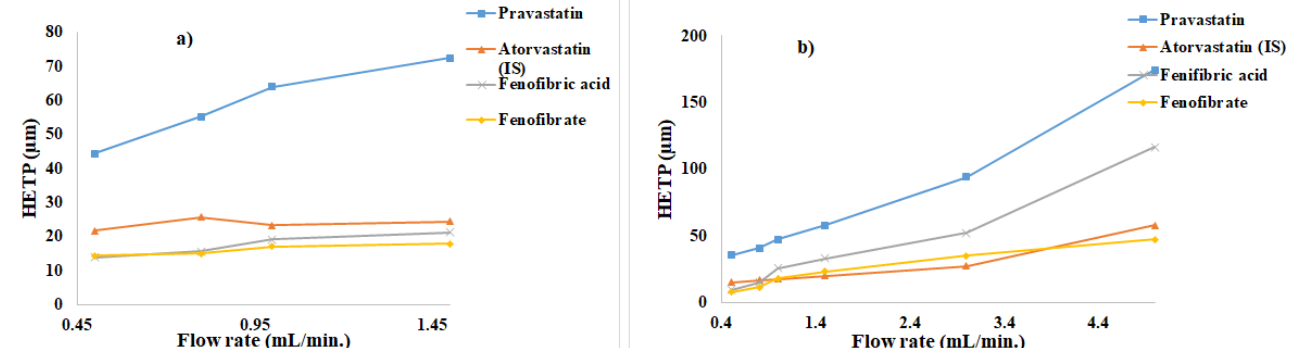
Figure 4. Van Deemter plot of the Height Equivalent to Theoretical Plates versus flow rate of ( a ) UHPLC column and ( b ) monolithic column for separation of the tested compounds.